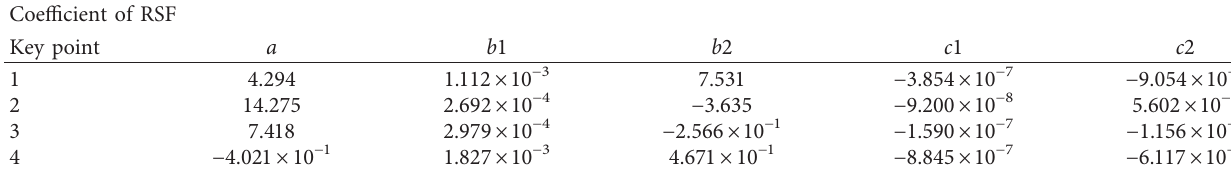
Table 4: Coefficient of response surface function.